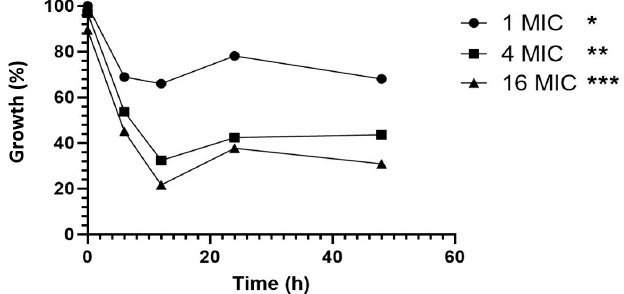
Figure 2. Growth kinetics of 10 A. fumigatus isolates with a percentual representation in report to the untreated control. Isolates were treated with LLCZ concentrations four times and 16 times the isolate specific MIC. Incubation took place at 35 °C for 48 h. The optical density was measured at 492 nm after 2 h, 6 h, 12 h, 24 h, and 38 h of incubation. Metabolically active cells were determined by incubation with 50 µL XTT (2.5 mg/mL) + menadione (125 mg/mL) per well (the XTT was added 2 h prior to incubation end). Statistical significance was determined by Dunnett’s multiple comparison tests, p < 0.05 was stated as significant and the confidence score was indicated by asterisks: *: p < 0.05, **: p < 0.01, ***: p < 0.001.